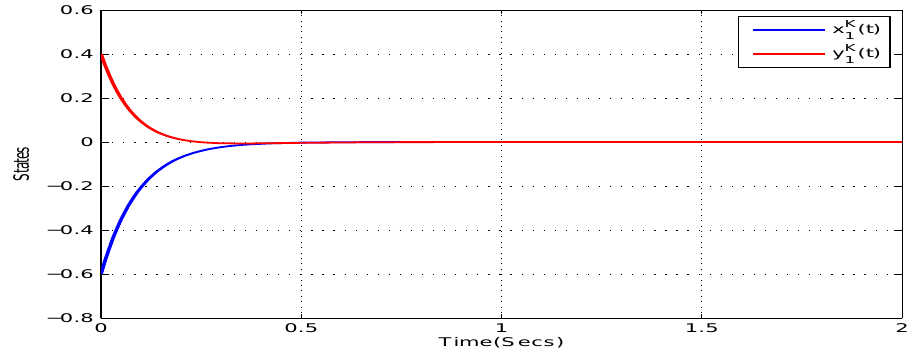
Figure 6. An illustration of the time responses with respect to the imaginary part pertaining to the states of ( t ) , y K ( t ) in Example x K 1 1